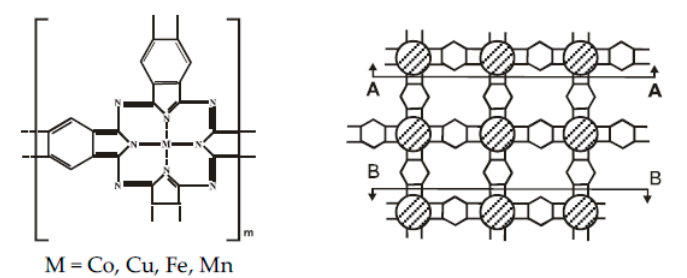
Figure 1. The structure polyphthalocyanine (oligophthalocyanine inside